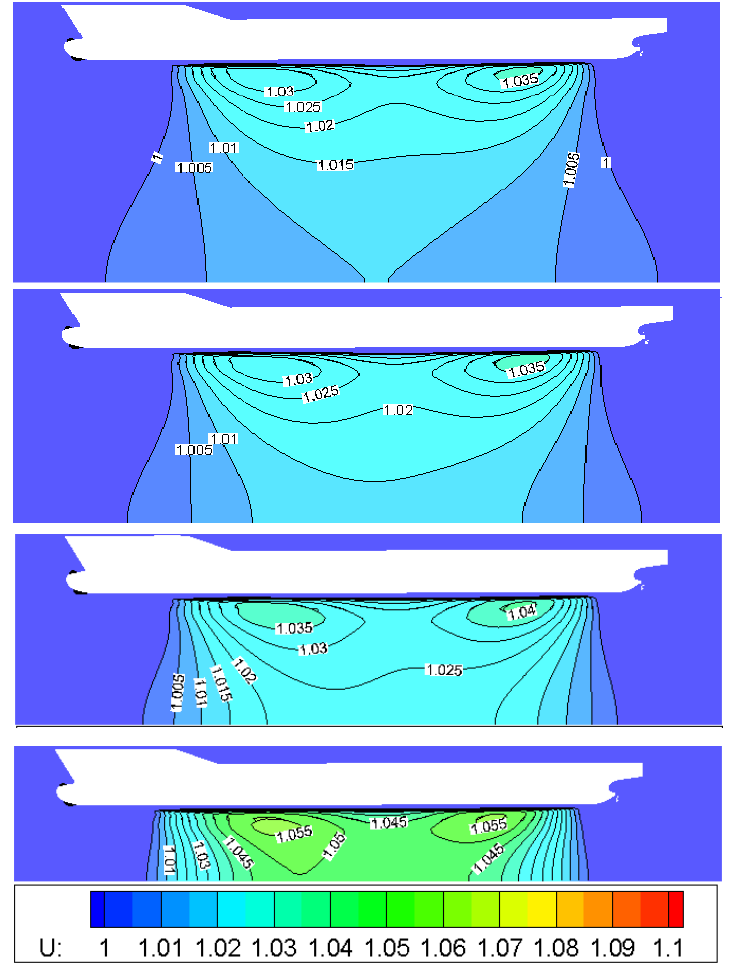
Figure 18. The overspeed ratios at di ff erent water depths for the 1:31.6 scaled model of the KCS (water depth decreases from top to bottom, corresponding to H = 4T, H = 6T, H = 8T, H = 10T